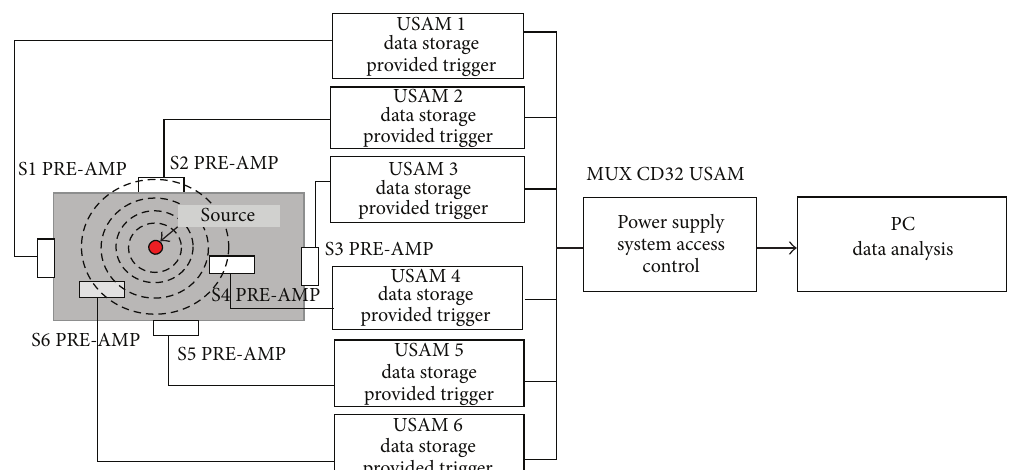
Figure 6: AE acquisition system.